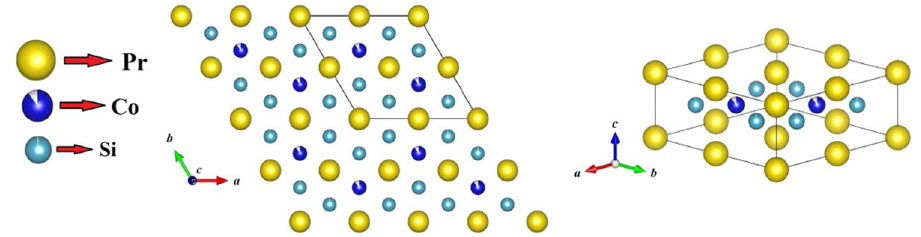
Figure 1. Crystal structure of Pr 2 Co 0.86 Si 2.88 belonging to the U 2 RuSi 3 -type structure (space group: P6/mmm ) that is considered as a superstructure of AlB 2 -type structure. The doubling of the “ a ” (and “ b ”) lattice parameters in the superstructure allows splitting of Wyckoff sites and a regular arrangement of Co and Si atoms, which otherwise would not be possible in the AlB 2 -type structure. The white sectors in the Co and Si atom symbols show the proportion of the site-vacancies as estimated from the XRD data. Unit cell is marked in the left